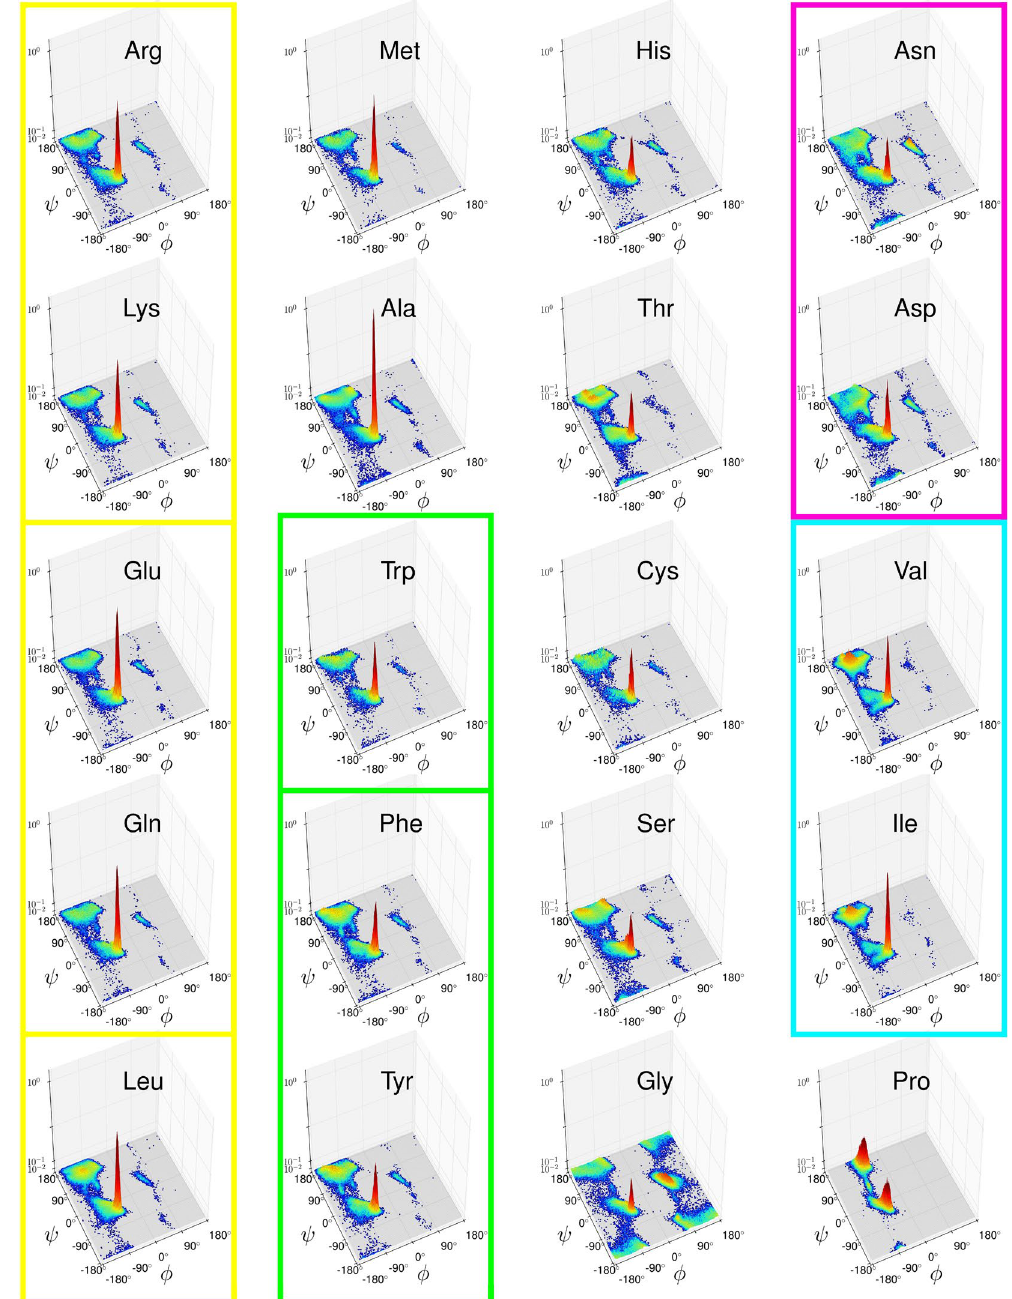
Figure 1. High-resolution Ramachandran probability distributions P X ( φ , ψ ) (logarithmic scale) as derived from the PGD 1.1 database at 1.895° × 1.895° bin size. Structurally similar open sets: yellow, S I = {{Arg, Lys}, {Glu, Gln}, Leu}; green, S II = {Trp, {Phe, Tyr}}; magenta, S III = {Ans, Asp}; cyan, S IV = {Val, Ile}. Ala, Met, and Ser have their first neighbor in S I ; His, Thr, and Cys are adjacent to S II . Larger images of each Ramachandran distribution are given by Supplementary Figs.